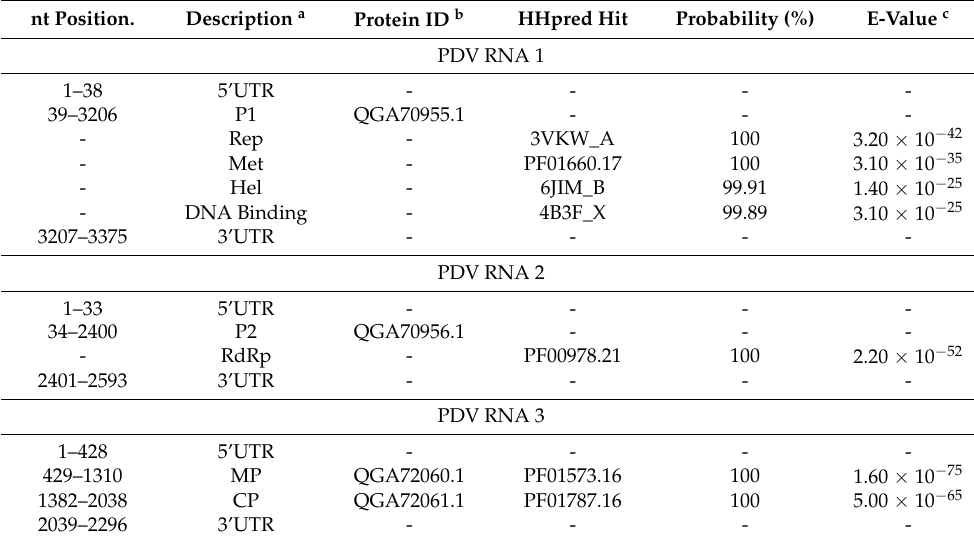
a UTR: untranslated region, Rep: replicase domain, Met: methyltransferase domain, Hel: helicase domain, RdRp: RNA dependent RNA polymerase, MP: movement protein, CP: coat protein. b Genbank protein identifiers were used in this study. c E-value: expected number of false positives per database search which scores the same or better than the sequence percent